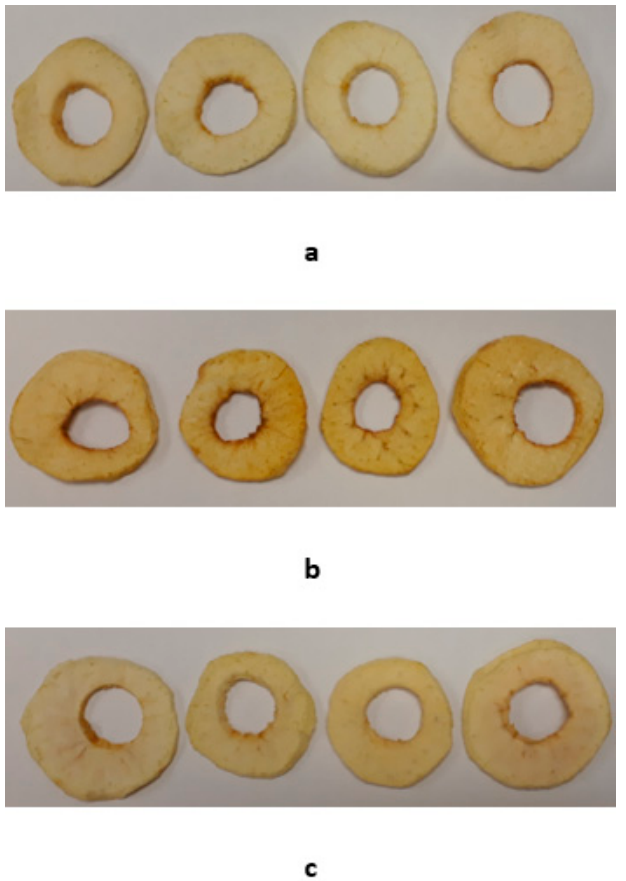
Figure 5 . Images of dried apple slices: ( a ) pre-treated with CMO, ( b ) control and ( c ) pre-treated with CMOP at 0 days storage .